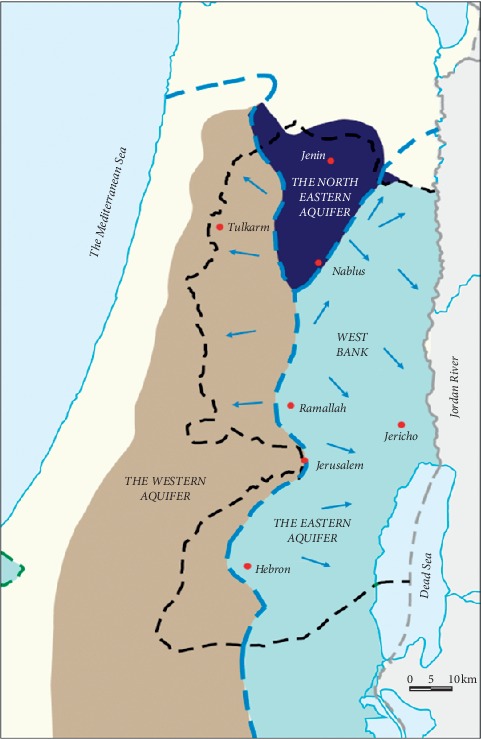
The major aquifers in the West Bank [17].